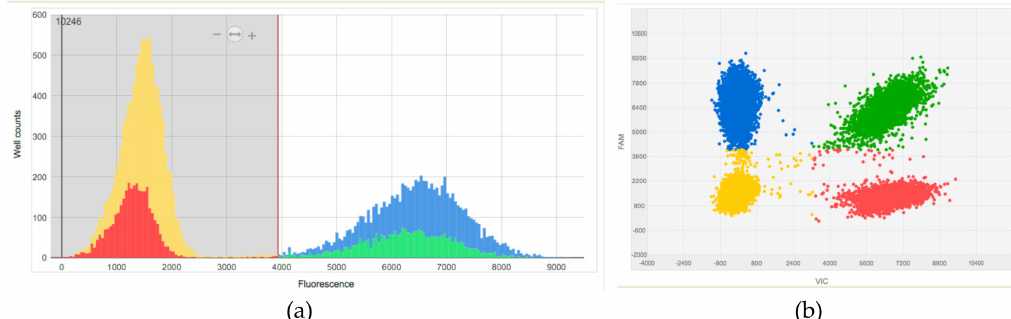
Figure 2. An example of a dPCR result histogram and scatterplot indicating the trisomy of chromosome 21 generated using QuantStudio 3D AnalysisSuite Cloud Software v3.1. ( a ) dPCR result histogram is generated by plotting an overview of the observed dye intensities (fluorescence) versus well count for every well on the chip. Red vertical line represents the fluorescence (call) threshold for chips calculated automatically in an Absolute Quantification project by the software. The yellow peak show unamplified wells (no target). The blue and red peak represents wells on the dPCR chip with target amplification (FAM and VIC reporter dye signal from each well). ( b ) The corresponding scatter plot showing signal from FAM reporter dye on the Y-axis against the signal from VIC reporter dye on the X-axis. All data points from every well on the dPCR chip are shown in the plot. The data points in the plot showing no signal (yellow), with only FAM reporter dye signal (blue), with only VIC reporter dye signal (red) and with both FAM and VIC reporter dye signal (green). In this study the following assays were used: probe on the chromosome 21 that generates a FAM-positive signal and probe on the reference chromosome 13, which generates a VIC-positive signal.